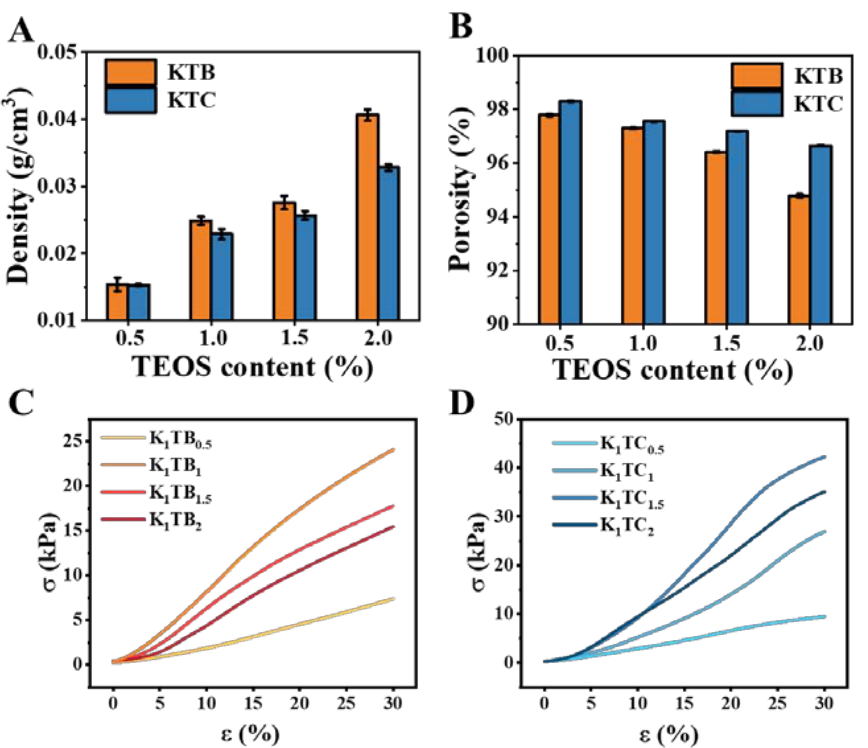
Figure 5. The density ( A ) and porosity ( B ) of KTB and KTC aerogels, and stress–strain curves for KTB aerogels ( C ) and KTC aerogels ( D ). KTB aerogels ( C ) and KTC aerogels ( D